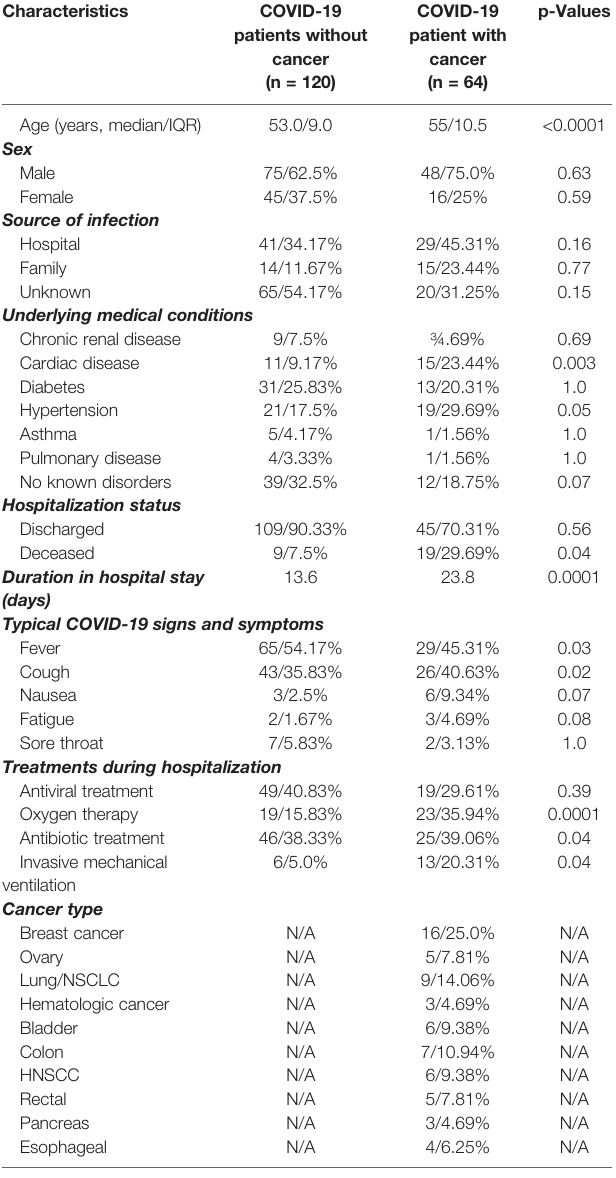
TABLE 1 | Characteristics of COVID-19-positive noncancer and cancer